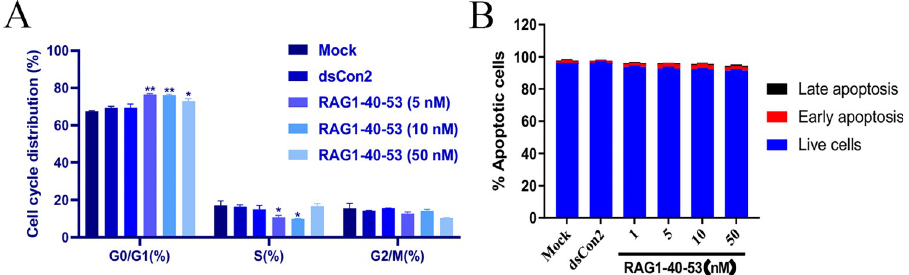
Fig 2. RAG1-40-53(saRNA) alleviated cell cycle and cell toxic in ARPE-19 cells. (A) Flow cytometry cycle of the control group and the transfection group with different concentrations of saRNA. Bar graph represents the quantitative data of RPE cell cycle distribution in Mock, dsCon2 and RAG1-40-53(1nM, 5nM, 10nM, 50nM) groups. Each value represents the mean ± SD of two independent experiments. Each performed in copies. The saRNA transfection group was significantly different from the control group ( � P < 0.05, �� P < 0.001). (B) Apoptosis analysis was used to determine whether saRNA (RAG1-40-53) was toxic to ARPE-19 cells. There was no significant difference in cytotoxicity between the transfected saRNA group and the control group. (P >